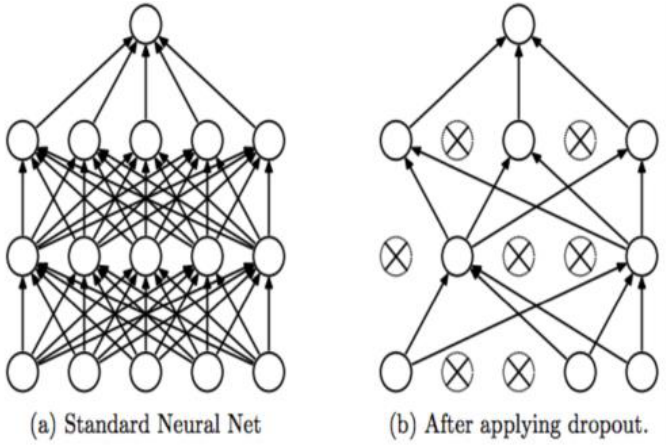
Figure 3. Representation of Dropout.